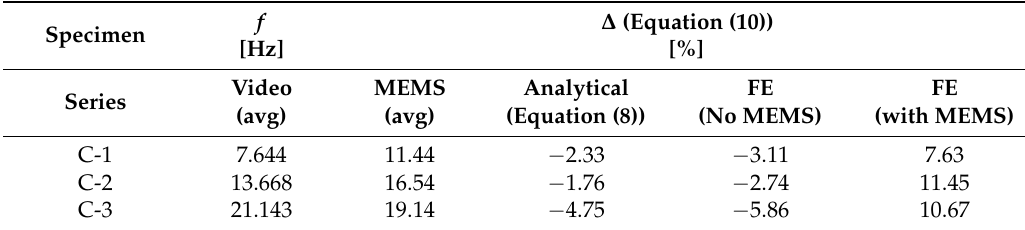
Table 3. Fundamental frequencies of C-type samples, as derived from video-camera records.